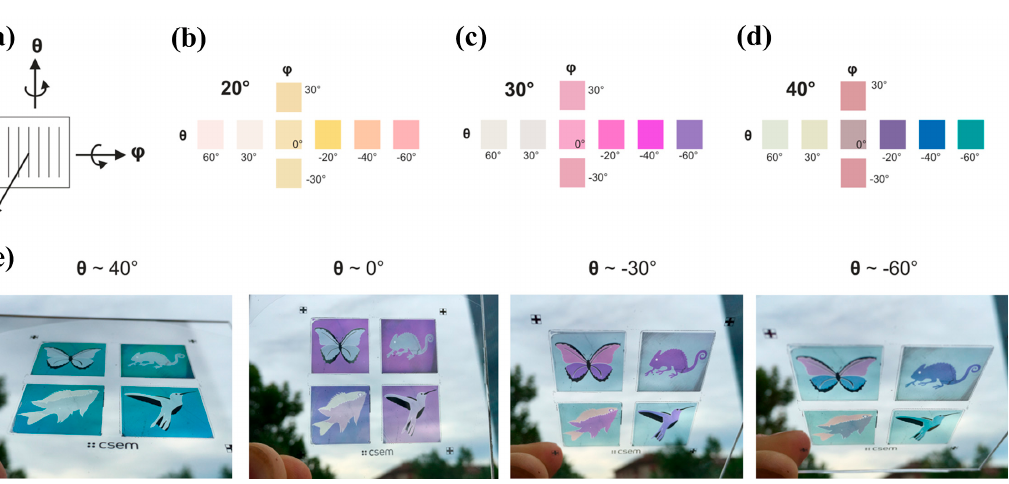
Figure 6. Optical images of the same sample of gold nanorods on a silicon substrate taken from varying angles. Different vivid colors of ( a ) red, ( b ) yellow, ( c ) green, and ( d ) blue are shown. Redshift of resonance colors with increasing tilting angles can be clearly observed. ( e ) Normalized specular reflections for various angles of incidence. ( f ) Magnetic field distributions near the interface between the nanorod array and the silicon substrate at varying incident angles of 30 (top row), 50 (middle row), and 70 (bottom row) degrees and different wavelengths of 670 (left column), 570 (middle column), and 490 (right column). All figures are adapted from reference [92].